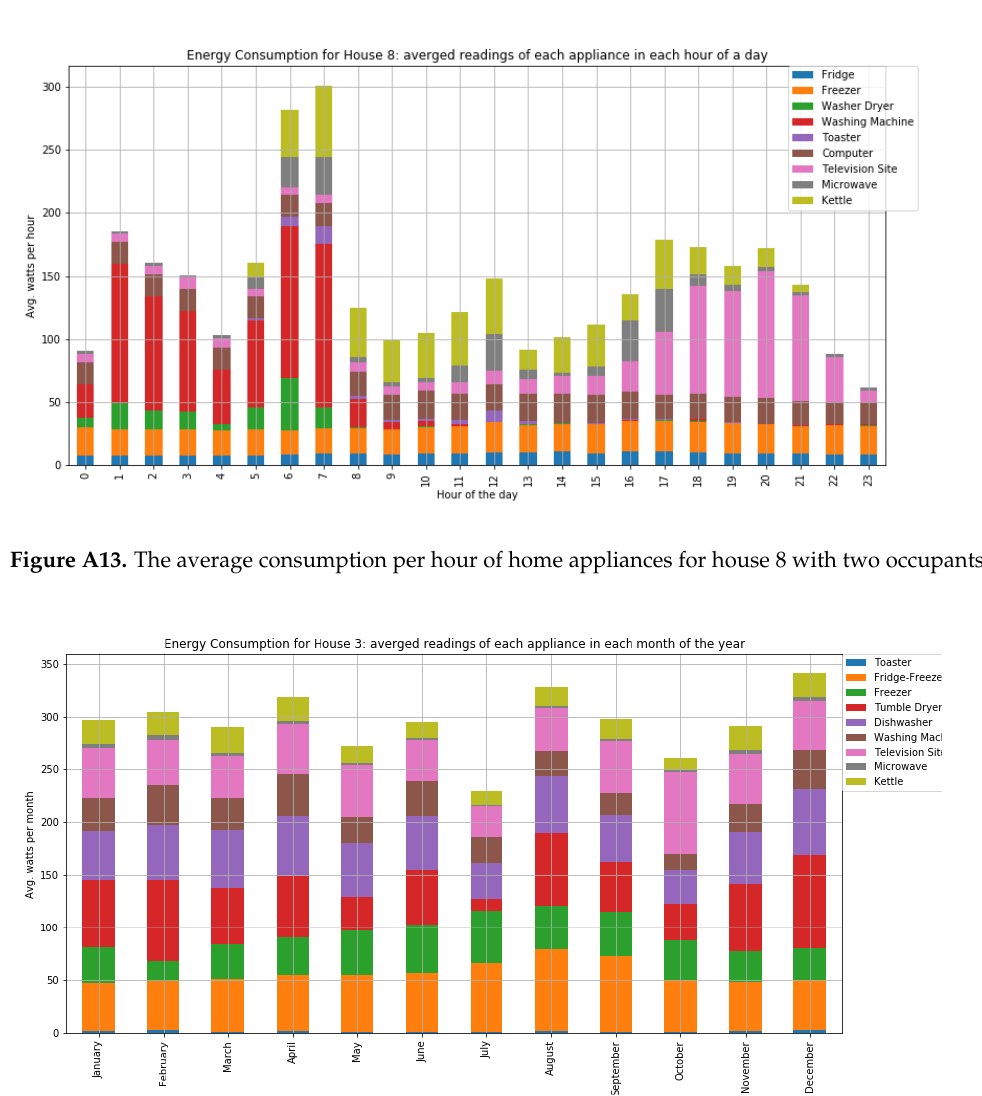
Figure A14. The average consumption per month of home appliances for house 3 with two occupants.